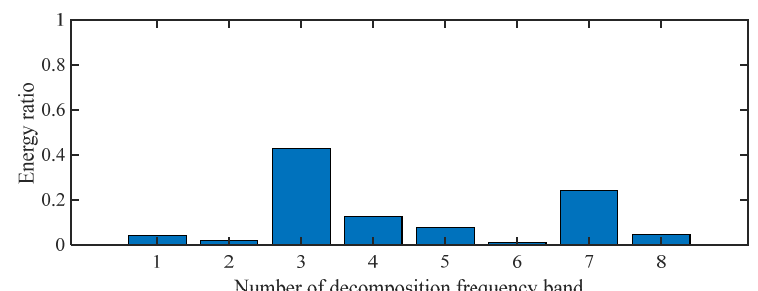
Figure 11. Energy distribution proportional histogram of the vibration signal. Appl. Sci. 2020 , 10 , x FOR PEER REVIEW